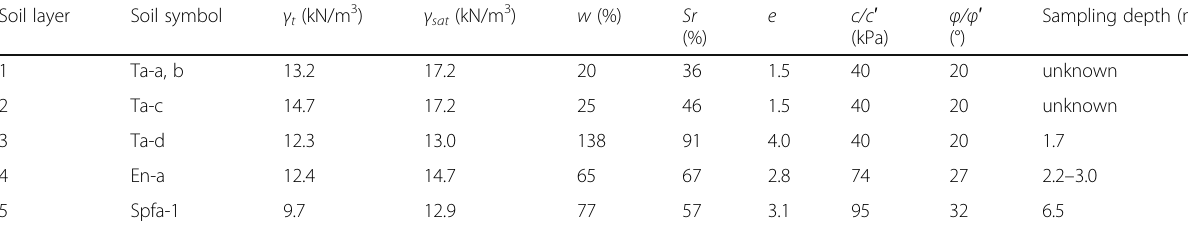
Table 2 Geotechnical parameters of the pyroclastic fall deposits in the study area Soil layer Soil